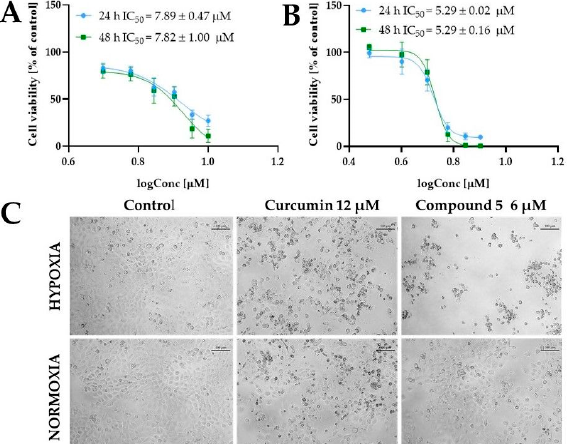
Figure 10. The cytotoxic effect of compound 5 against bladder cancer 5637 cells under normoxic and hypoxic (1% of oxygen) conditions. The cells were treated with compound 5 at a concentration of 5 µ M, 6 µ M, 7 µ M, 8 µ M, 9 µ M, and 10 µ M (normoxic conditions), and 3 µ M, 4 µ M, 5 µ M, 6 µ M, 7 µ M, and 8 µ M (hypoxic conditions) for 24 h ( A ) and 48 h ( B ). Cell viability was determined by MTT assay. Data are presented as mean values ± SD calculated from at least two independent experiments. Panel ( C ) presents the representative images of cell morphology after treatment with compound 5 at a concentration of 6 µ M for 24 h under both hypoxic and normoxic conditions. The 5637 cells’ morphology after treatment with curcumin (12 µ M) for 24 h is also shown for comparison. The images were taken with a DS-SMc digital camera attached to a Nikon Eclipse TS100 microscope. The scale bar corresponds to 100 µ m.